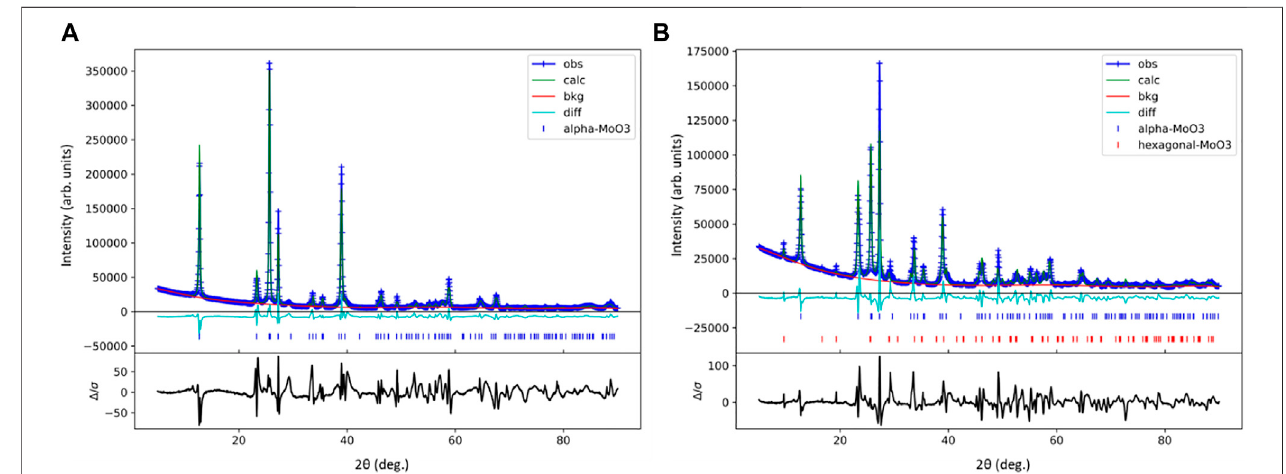
Frontiers in Chemistry |